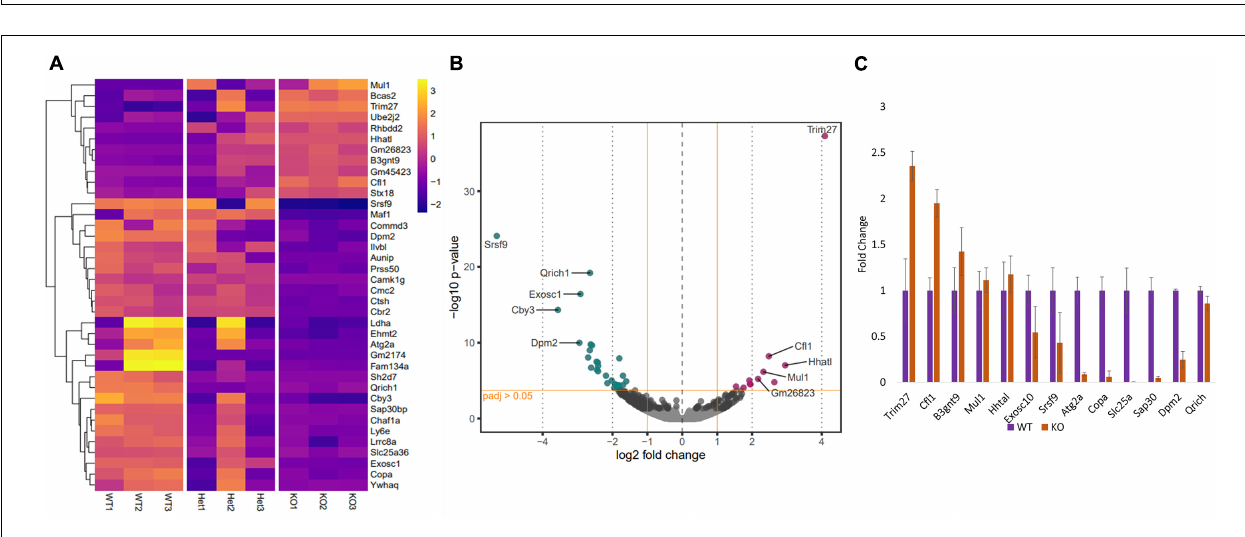
FIGURE 7 | Changes in gene expression profile of Pfn3 -deficient mice. (A) Heat map visualization of top 38 differentially expressed (DE) genes obtained by RNA-seq on Pfn3 + / + , Pfn3 + / − , and Pfn3 − / − testes. (B) Volcano plots displaying DE genes for Pfn3 + / + vs. Pfn3 − / − [adjusted p -value < 0.05; log2 fold change of expression (LFC) > 1.5]. (C) DE genes obtained by RNA-seq were verified by qRT-PCR on Pfn3 + / + , Pfn3 + / − , and Pfn3 − / − testicular RNA ( n = 3 biological